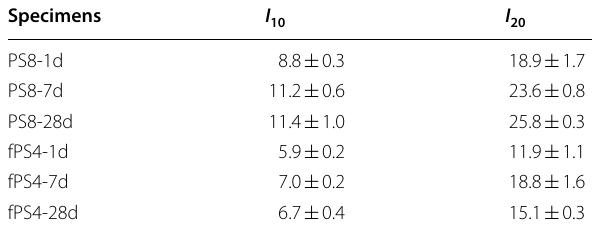
Table 4 Effects of curing age on ductile index and toughness index of fibre-reinforced MPC.